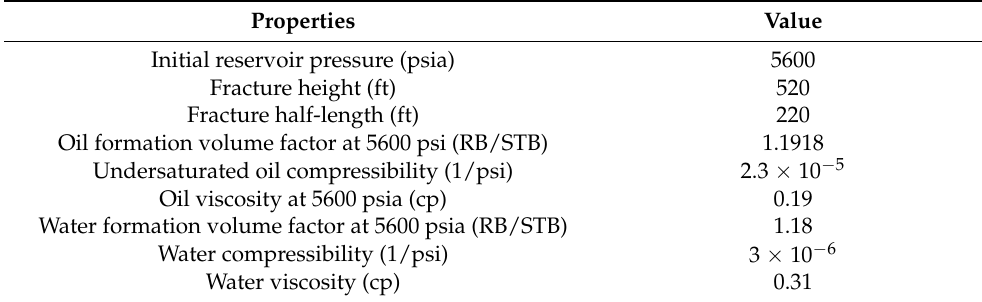
Table 4. Fixed reservoir and fluid properties used for semi-analytical model forecasting runs.